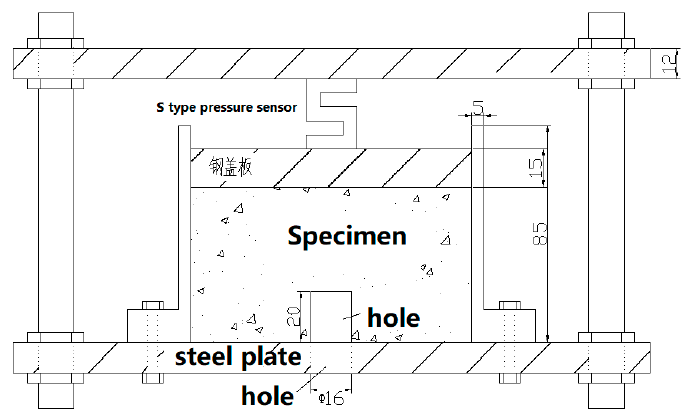
Figure 7. Cross-section of the model test device with pressure sensor.